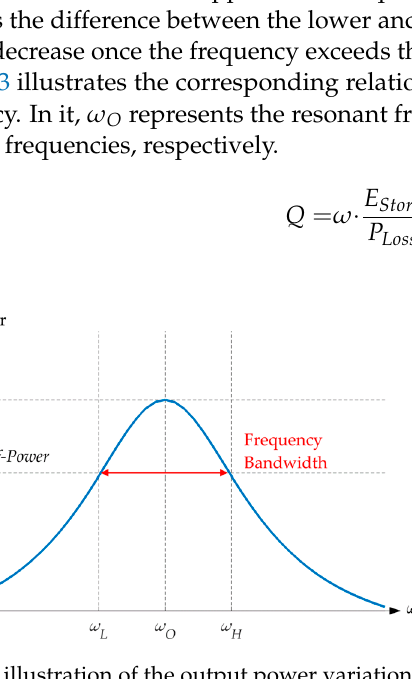
Figure 3. The illustration of the output power variation in different frequencies.